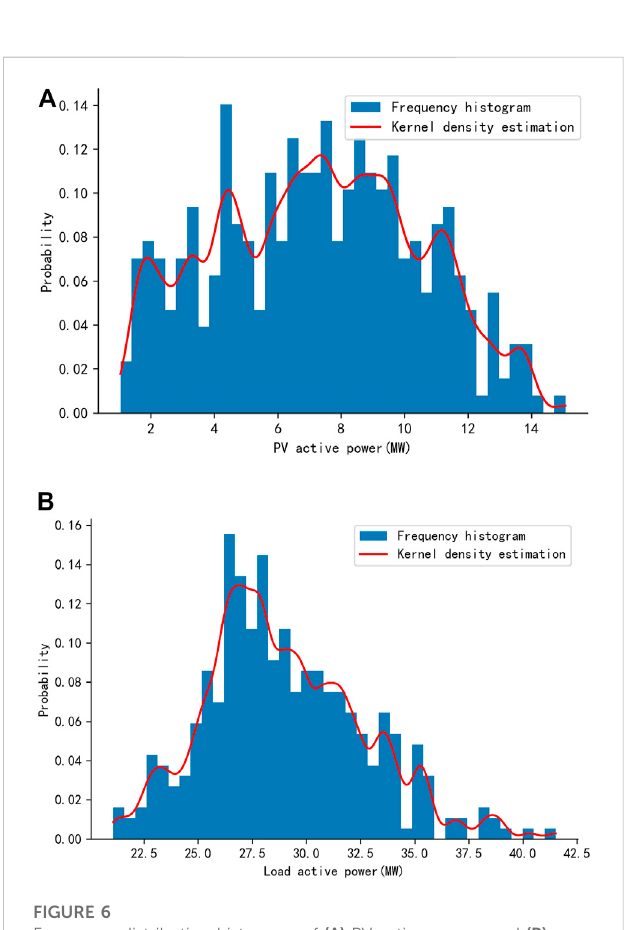
Frequency distribution histogram of (A) PV active power, and (B) load active power at 9 a.m. and their fi tting results.